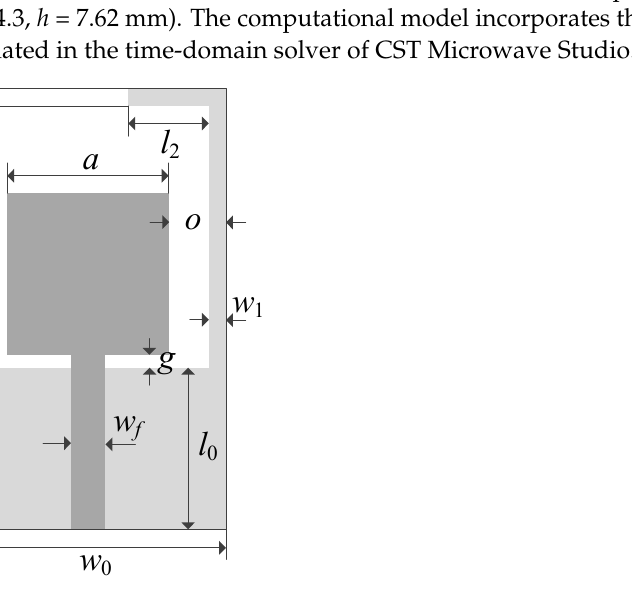
Figure 7. Antenna II: representative run of the proposed algorithm with automated adjustment of the penalty factors: ( a ) reflection coefficient at the initial (- - -) and optimized design ( — ); ( b ) evolu- tion of the penalty coefficient throughout the algorithm iterations.